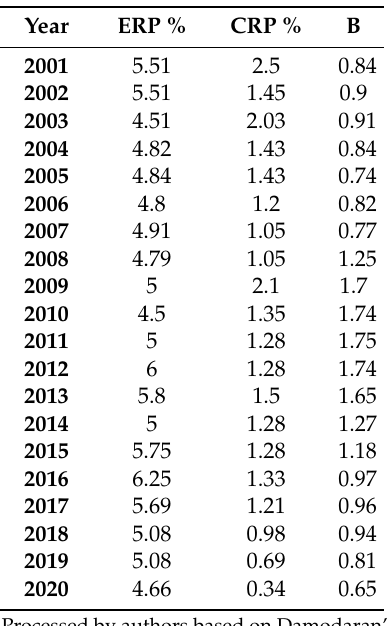
Table 6. The development and prediction of external risks.